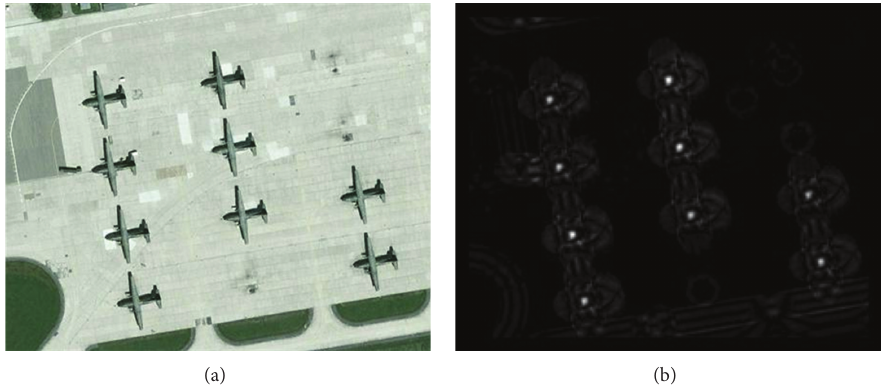
Figure 3: Illustration of CF-filter. (a) Original image; (b) CF-filtered